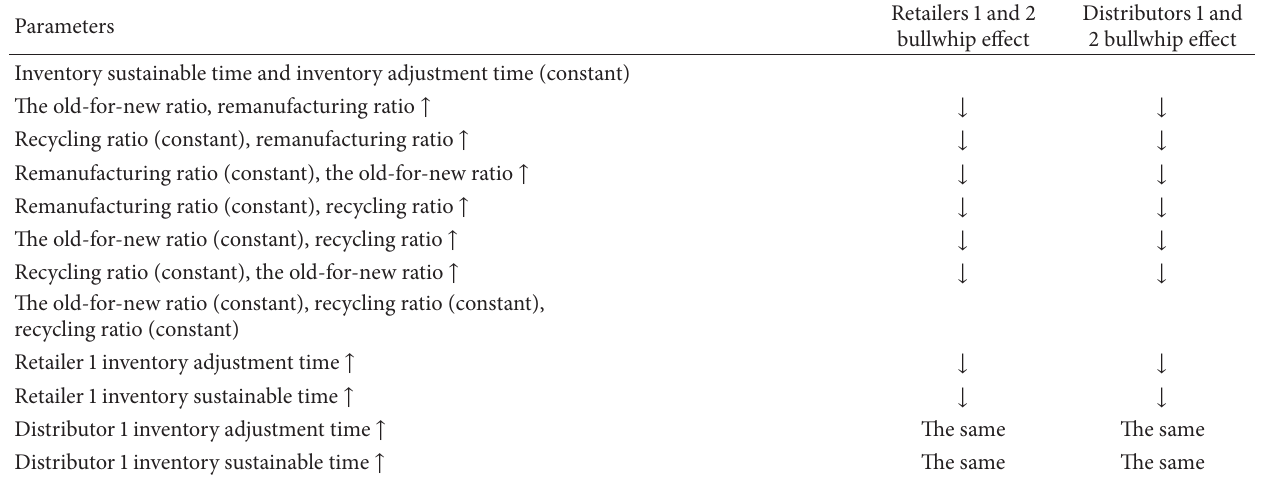
Table 4: Sensitivity analysis in electrical products closed-loop supply